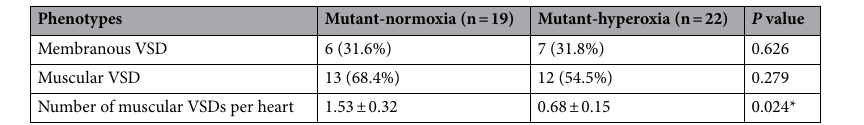
Table 1. Summary of cardiac anomalies of P1 Nkx2-5 mutant mice with or without hyperoxia. The one- sided Fisher’s exact test was used on a 2 × 2 contingency table for calculation of P values for incidence of membranous or muscular VSDs. * P ≤